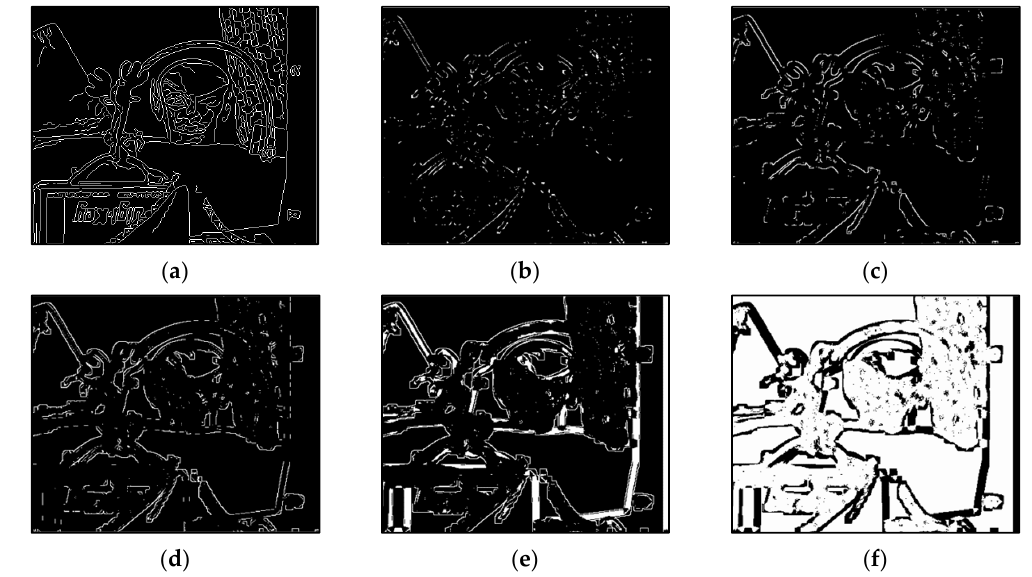
Figure 11. The results of Reindeer by AWCT. ( a ) Edge information and schematic diagrams of the biggest window size in ( b ) 13 × 13, ( c ) 15 × 15, ( d ) 17 × 17, ( e ) 19 × 19, and ( f ) 21 × 21